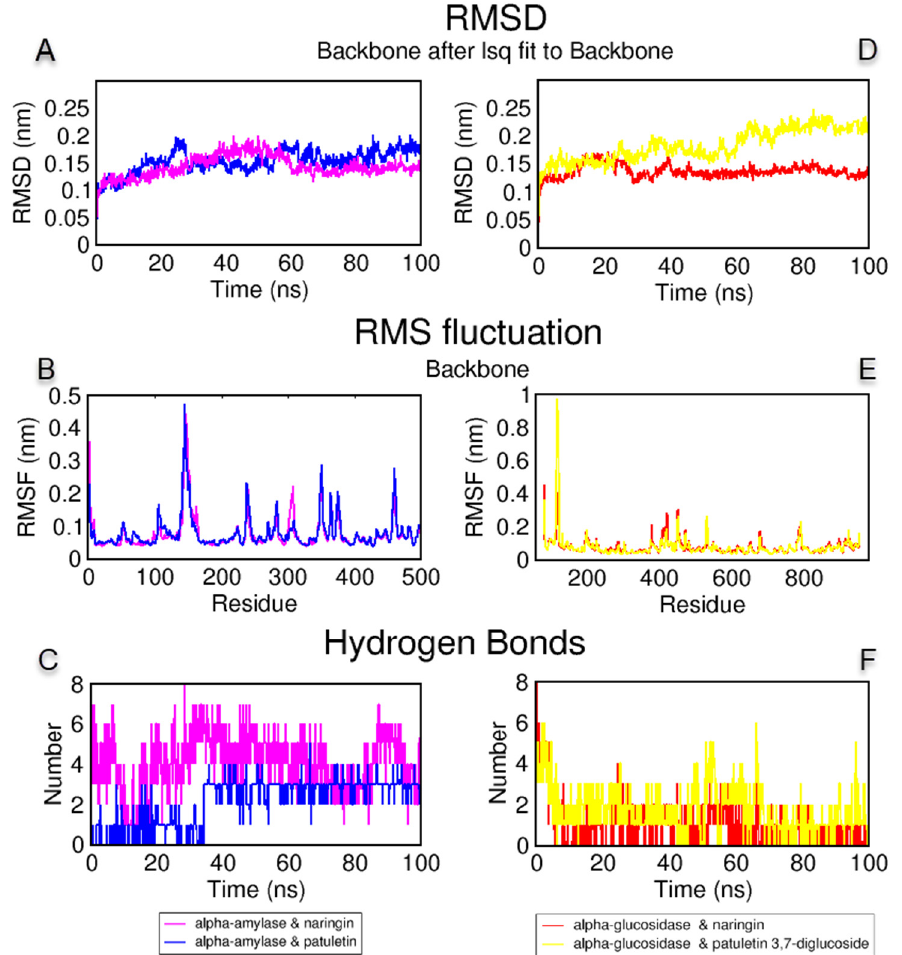
Figure 5. ( A – C ) The root mean square deviation (RMSD), root mean square fluctuation (RMSF) and protein–ligand hydrogen bond analysis and naringin and α -amylase and patuletin and α -amylase complexes; ( D – F ) RMSD, RMSF, H bonds plots of complexes naringin and α -glucosidase and patuletin 3,7-diglucoside and α -glucosidase for 100 ns.